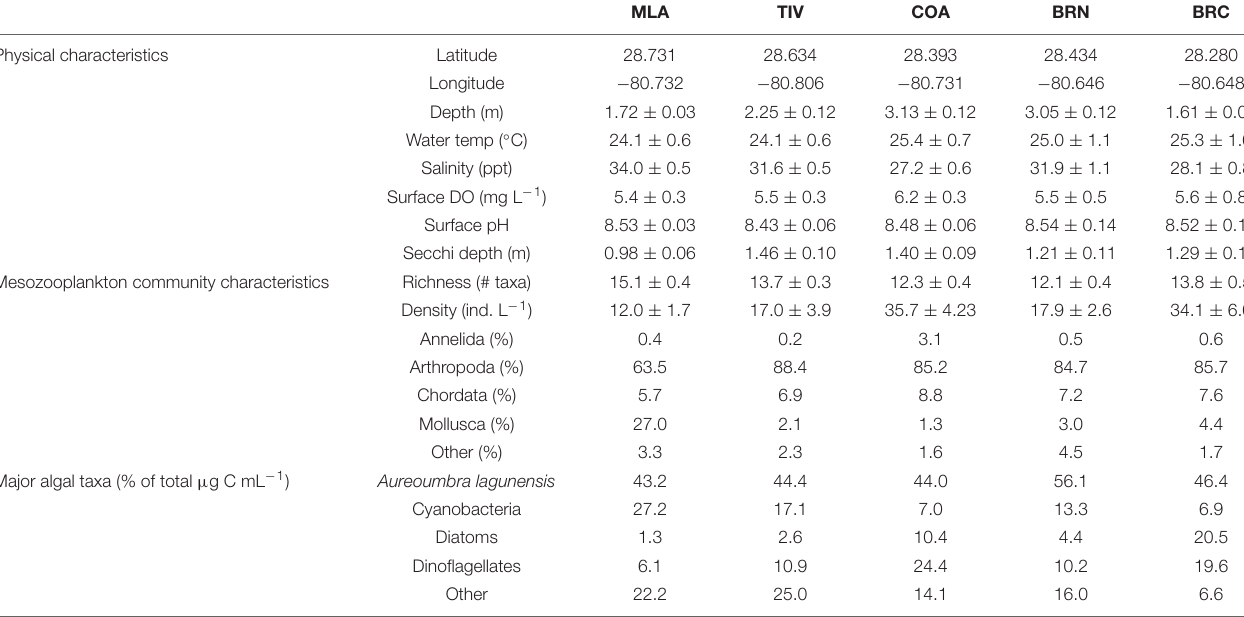
TABLE 1 | Key physical and biological characteristics of all five sampling sites.